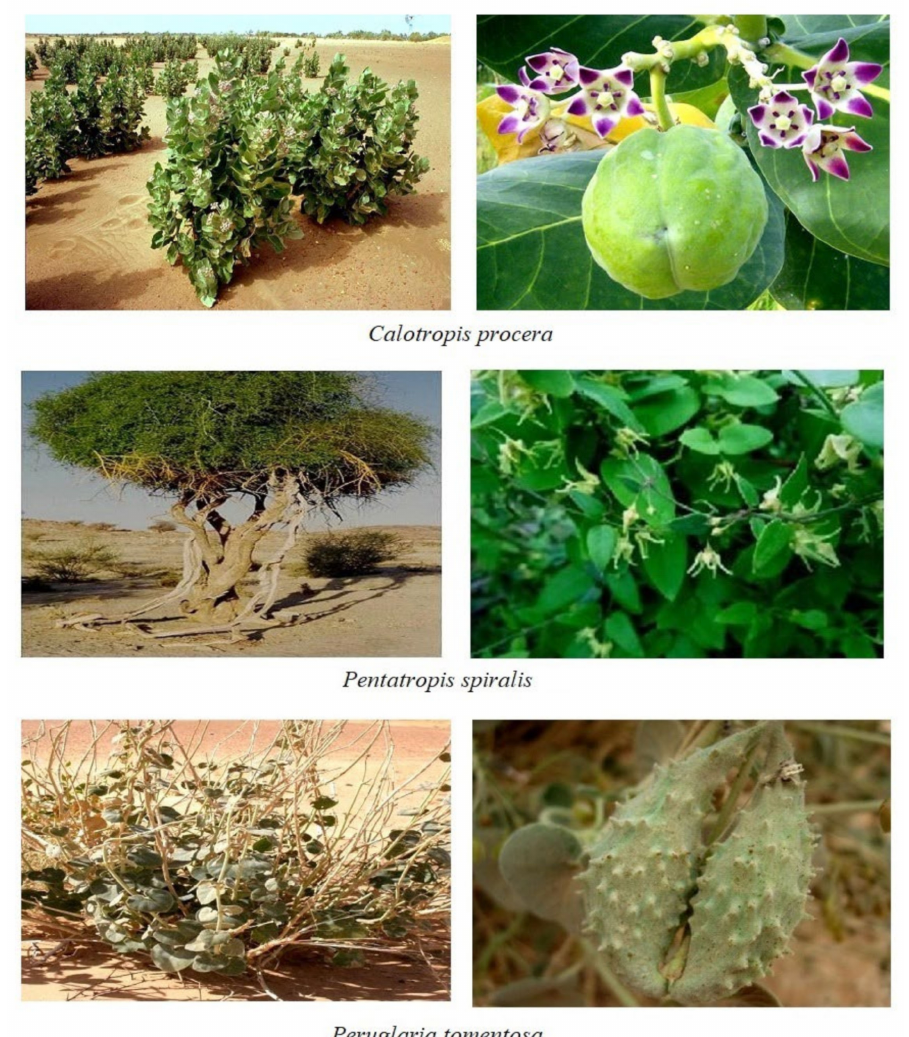
Figure 1. Plants used in this